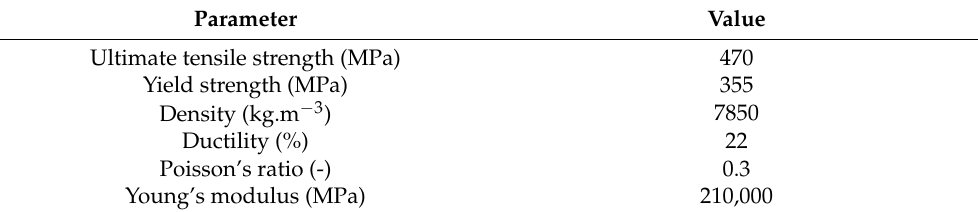
Table 4. Basic parameters of steel S355J0